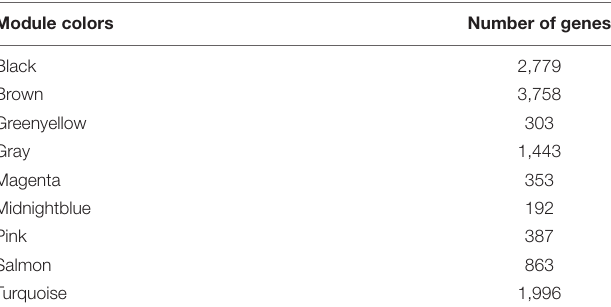
and greenyellow (303 genes; r = 0.85, p = 1e − 11) modules were negatively correlated with tubulointerstitial lesions in